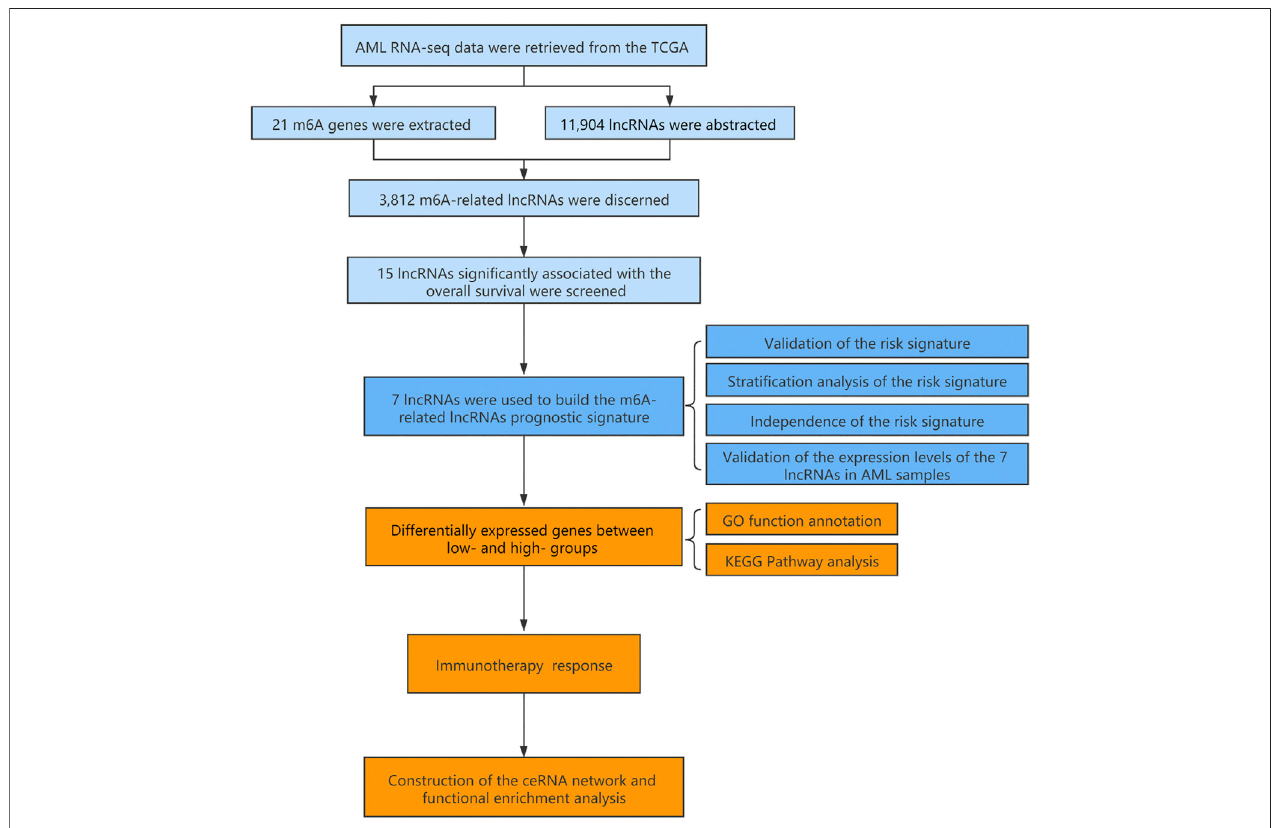
FIGURE 1 | Flow chart of the design in the